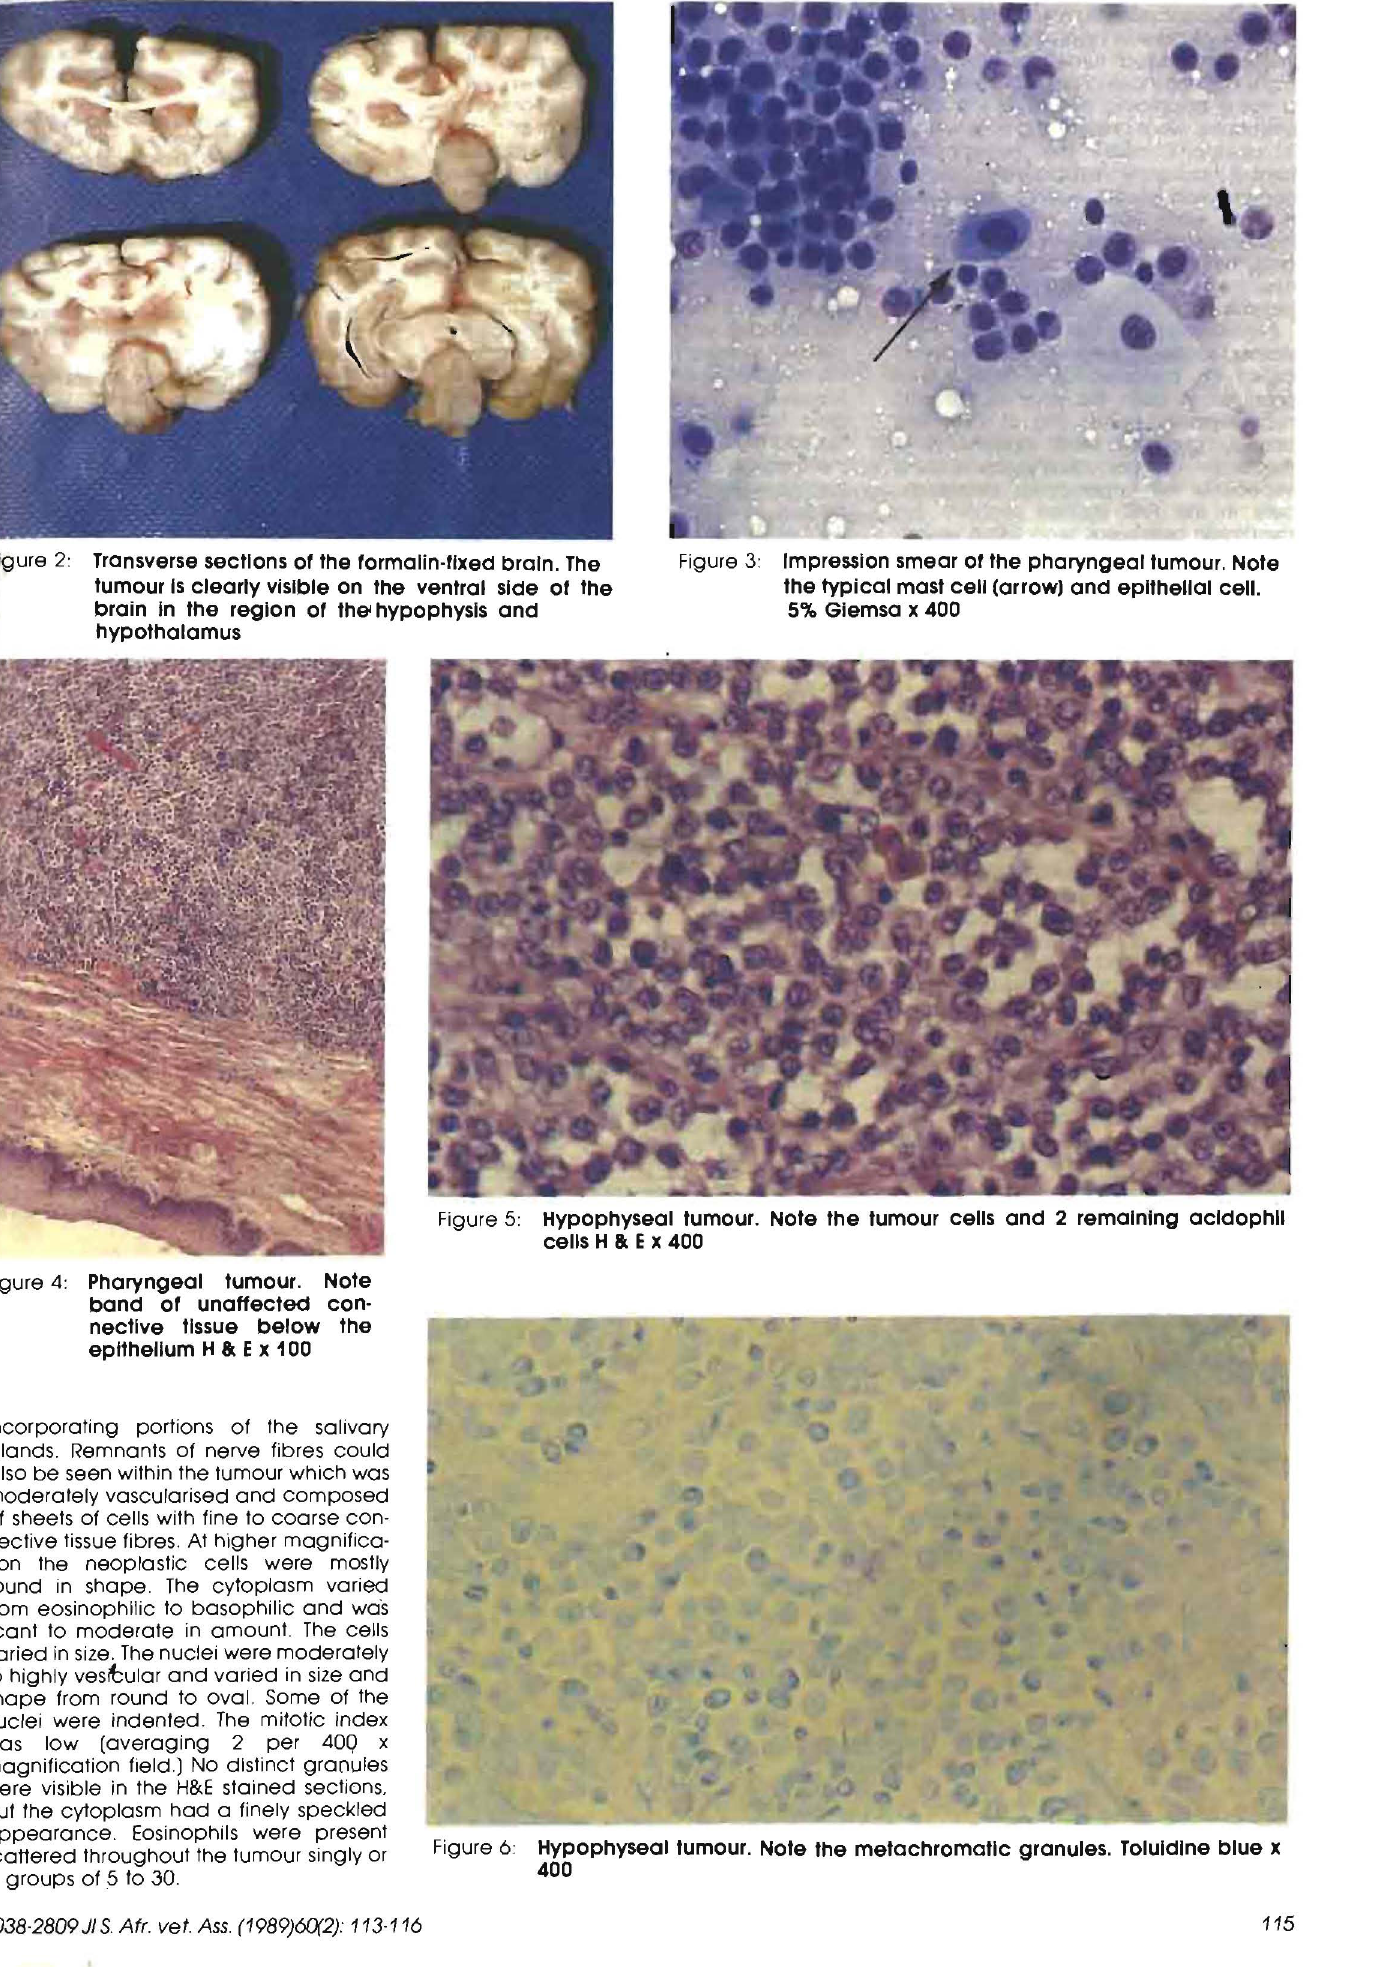
Figure 3: Impression smear Of the pharyngeal tumour. Note